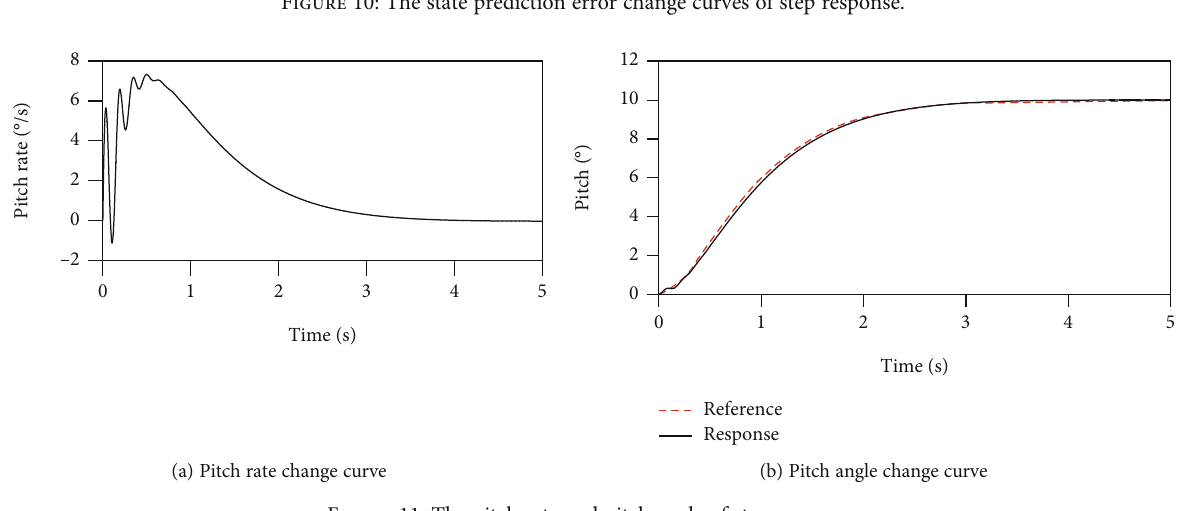
Figure 11: The pitch rate and pitch angle of step response.